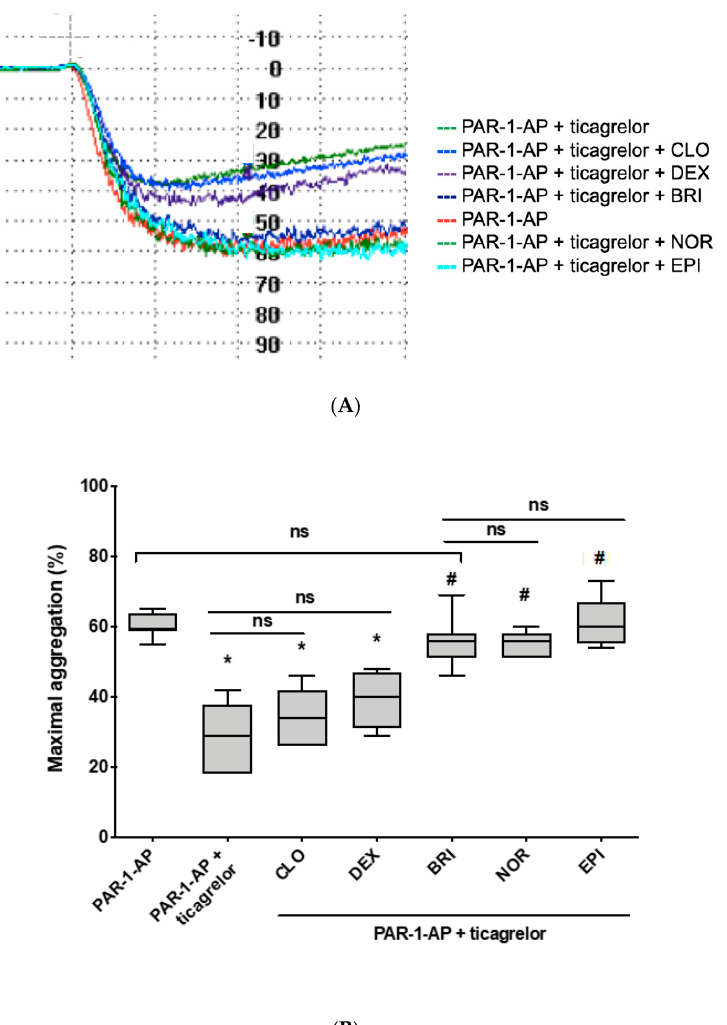
Figure 3. Norepinephrine and brimonidine restore PAR-1-AP-induced platelet aggregation inhibited by ticagrelor, while clonidine and dexmedetomidine are ineffective. Washed platelet aggregation on stimulation with different agonists (2 µM PAR-1-AP alone or in combination with clonidine (CLO, 10 µM), dexmedetomidine (DEX, 8 µM), brimonidine (BRI, 10 µM), norepinephrine (NOR, 10 µM), or epinephrine (EPI, 10 µM)), in the presence of ticagrelor. ( A ) Typical time-course of platelet aggregation using light transmission aggregometry. ( B ) Comparison of percentage of the maximal aggregation ( n = 7). Boxes represent the interquartile range and the median value, whiskers and the minimum and maximum values observed. All samples were compared with PAR-1-AP alone (* p < 0.01 vs. PAR-1-AP alone) or PAR-1-AP in the presence of ticagrelor (# p < 0.05 vs. PAR-1-AP + ticagrelor).